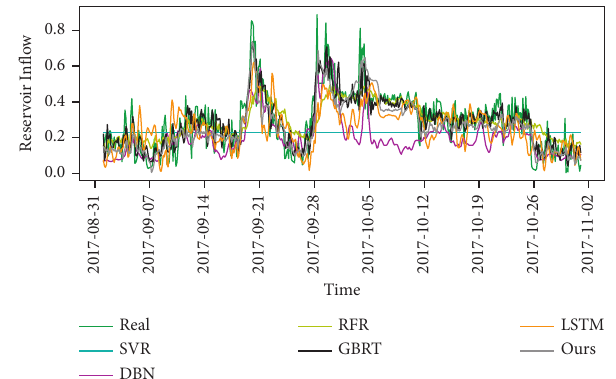
Figure 12: The predicted results over testing period for 24h lead